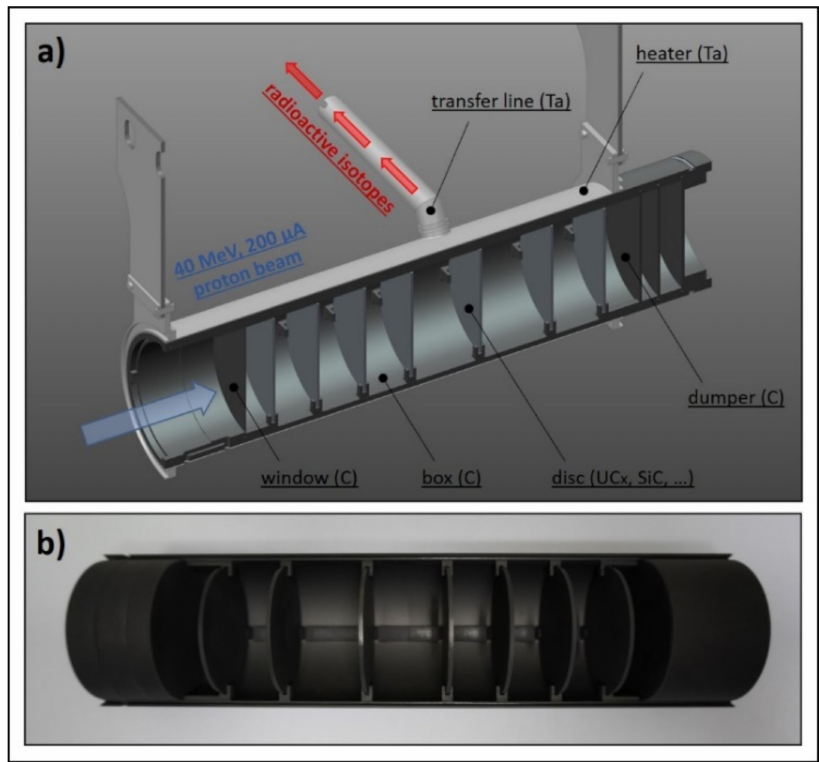
Figure 1. The SPES target architecture; ( a ) CAD view with indication of the main components;